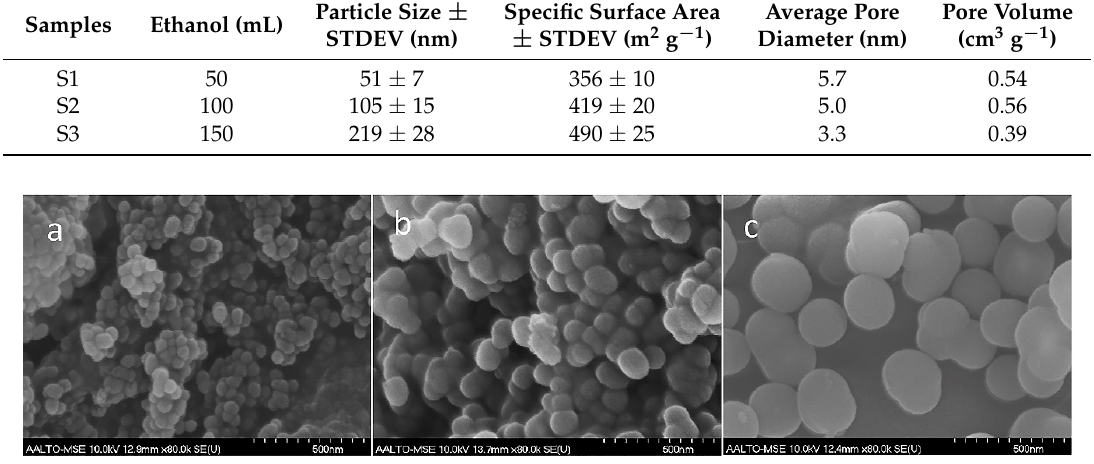
Figure 2. SEM images of surface morphology of dried powder samples: ( a ) S1, ( b ) S2, and ( c ) S3.